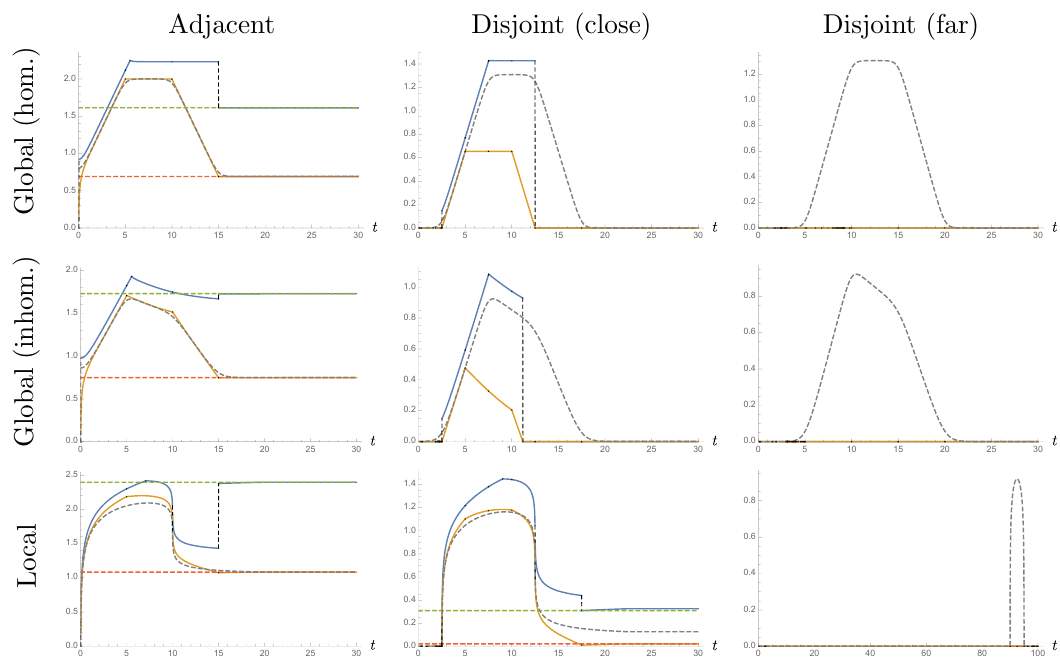
Figure 14 . Half of mutual information (orange), E W (blue), universal result from (2.27) (grey dotted). For the global quenches, the red and green dotted lines are the thermal values. For the local quench, they are the ground state values. For the local quench, we need to take the intervals to be very far away and (cid:15) (cid:12)nite in order for E W to vanish at all times. This behavior was observed for mutual information in ref.